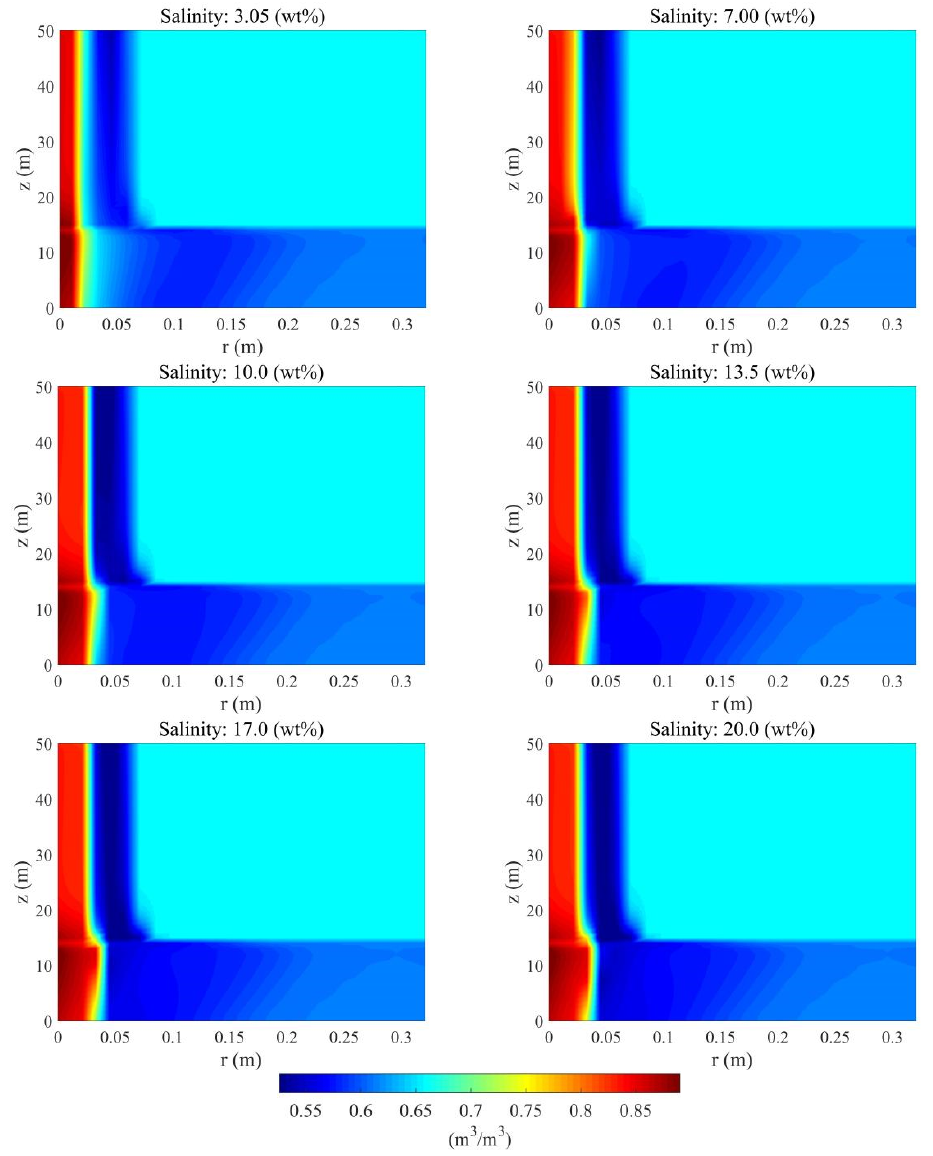
Figure 15. Comparison of two-dimensional water saturation distribution of hydrate reservoirs for a fixed temperature of 16 °C at the 24th hour of drilling fluid invasion under various drilling fluid salinity values.